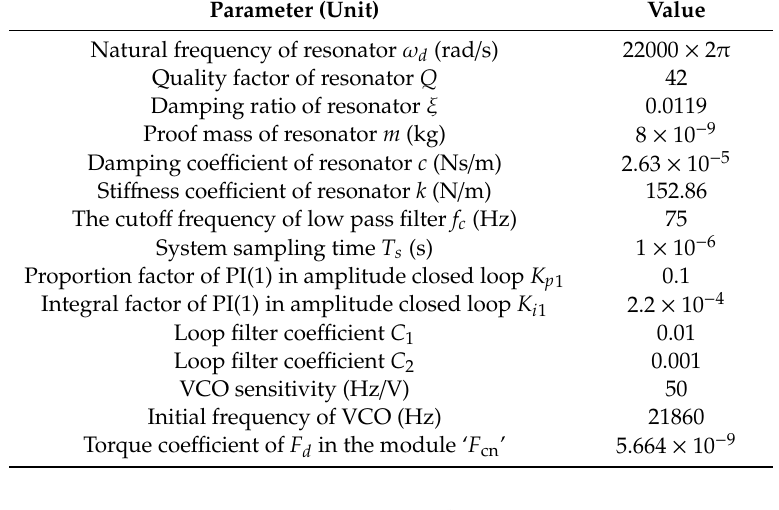
Figure 9. Simulink simulation model of the measurement and control circuit. Table 2. Sensor parameters and system simulation parameters.